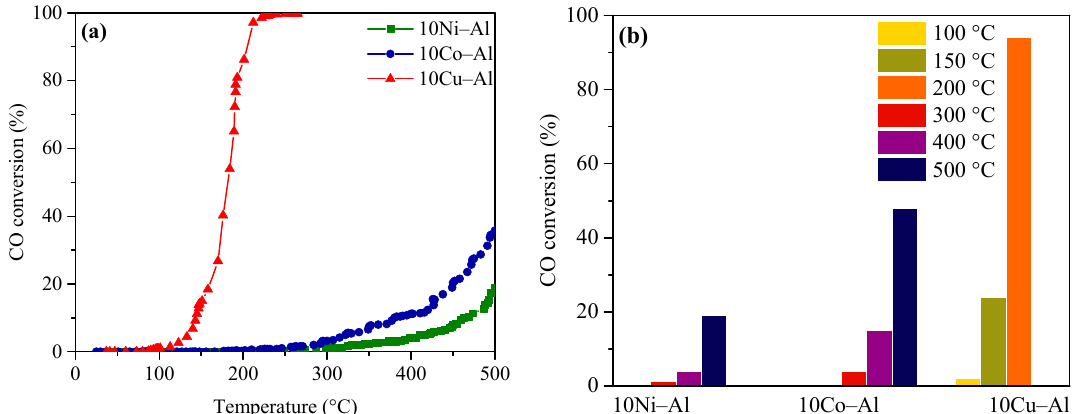
Figure 8. ( a ) CO conversion and ( b ) effect of reaction temperature on CO conversion over the calcined catalysts. Table 2. The light-off temperature of catalyst samples for CO oxidation.